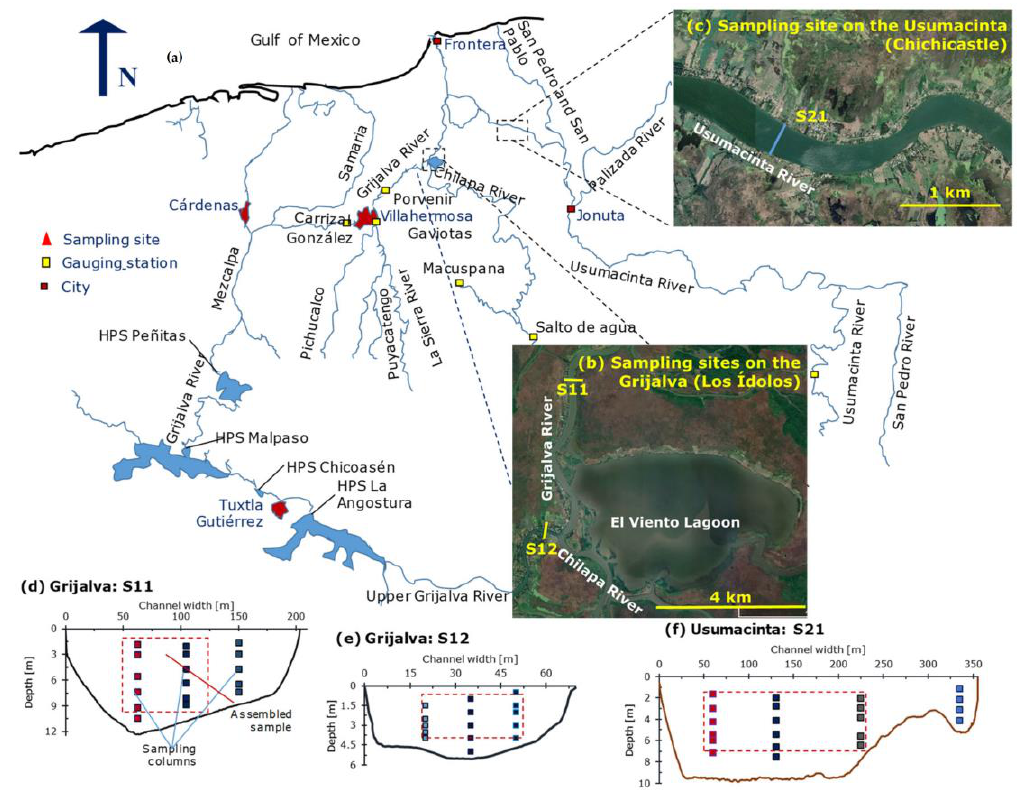
Figure 1. Study area and sampling strategy: ( a ) Grijalva-Usumacinta System. Sampling sites: ( b ) Los Í dolos (lower Grijalva), and ( c ) Chichicastle (lower Usumacinta). Sampling columns across the channel: ( d ) Grijalva (high-flow and rising-flow); ( e ) Grijalva (low-flow); ( f )